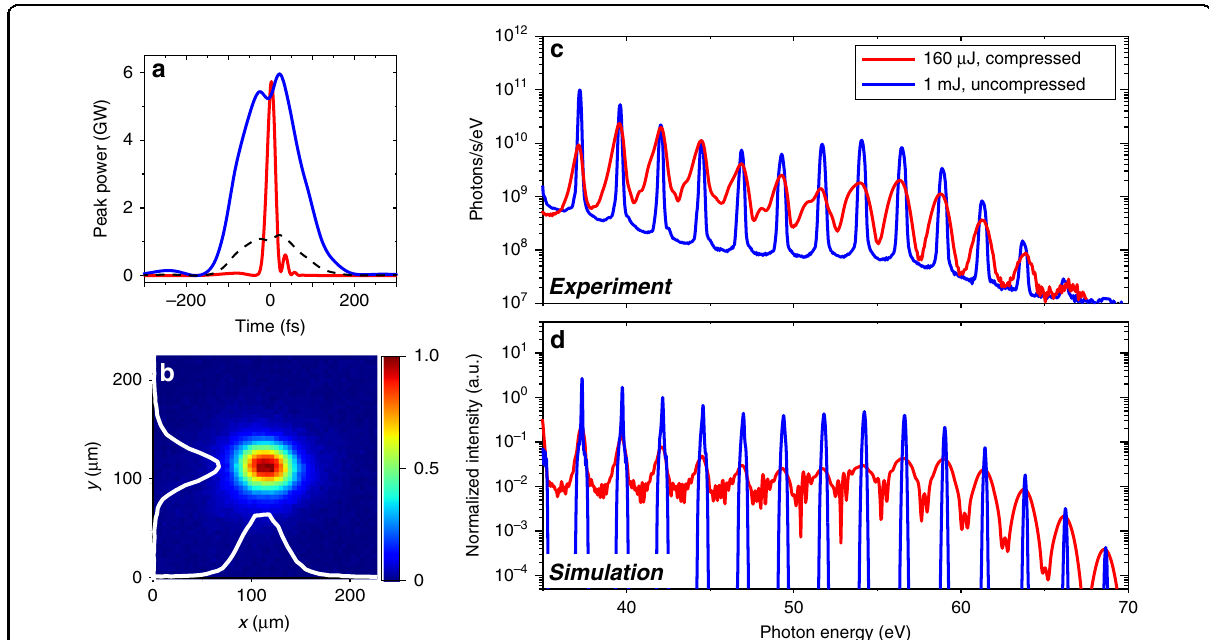
Fig. 4 Generation of bright HHG with the compressed pulses. a The temporal pro fi les and peak power of the 160 µJ, compressed (red) and 1 mJ, uncompressed (blue) pulses. The dashed line represents the pro fi le of the 160 µJ, uncompressed pulses for comparison. b The spatial pro fi le at the focus of the laser beam of the 160 µJ, compressed pulses. The white lines display the x and y transverse pro fi les of the beam. c Experimentally measured HHG spectra generated in argon by the 160 µJ, 50 kHz compressed pulses (red) and 1 mJ, 10 kHz uncompressed pulses under the same focusing conditions, reaching a fi eld intensity of ~1.4 × 10 14 W/cm 2 . d Simulation results of the HHG spectra under the same conditions as in ( c